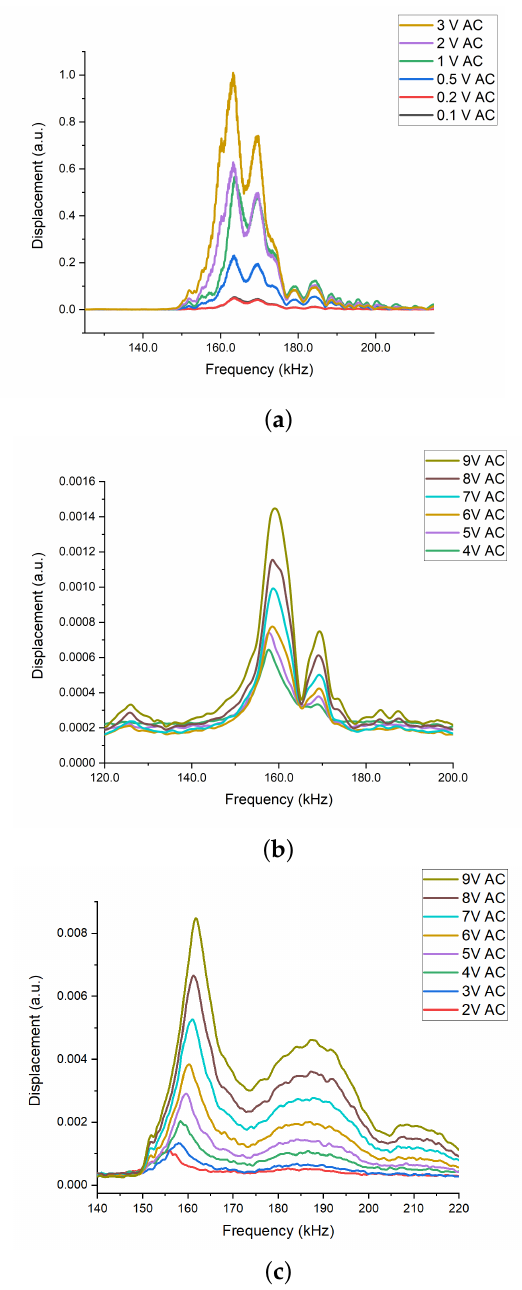
Figure 3. The frequency response of the membrane under ( a ) mechanical actuation with the input voltage from 0.1 V to 3 V AC and 1 V DC, as well as by the frequency sweep from 150 kHz to 220 kHz; ( b ) electro-static actuation with the voltage of constant 1 V DC voltage and varying AC from 4 V to 9 V with the frequency sweep between 120 kHz and 200 kHz; ( c ) electro-thermal frequency sweep signal with 2–9 V AC and 1 V DC between 140 kHz and 220